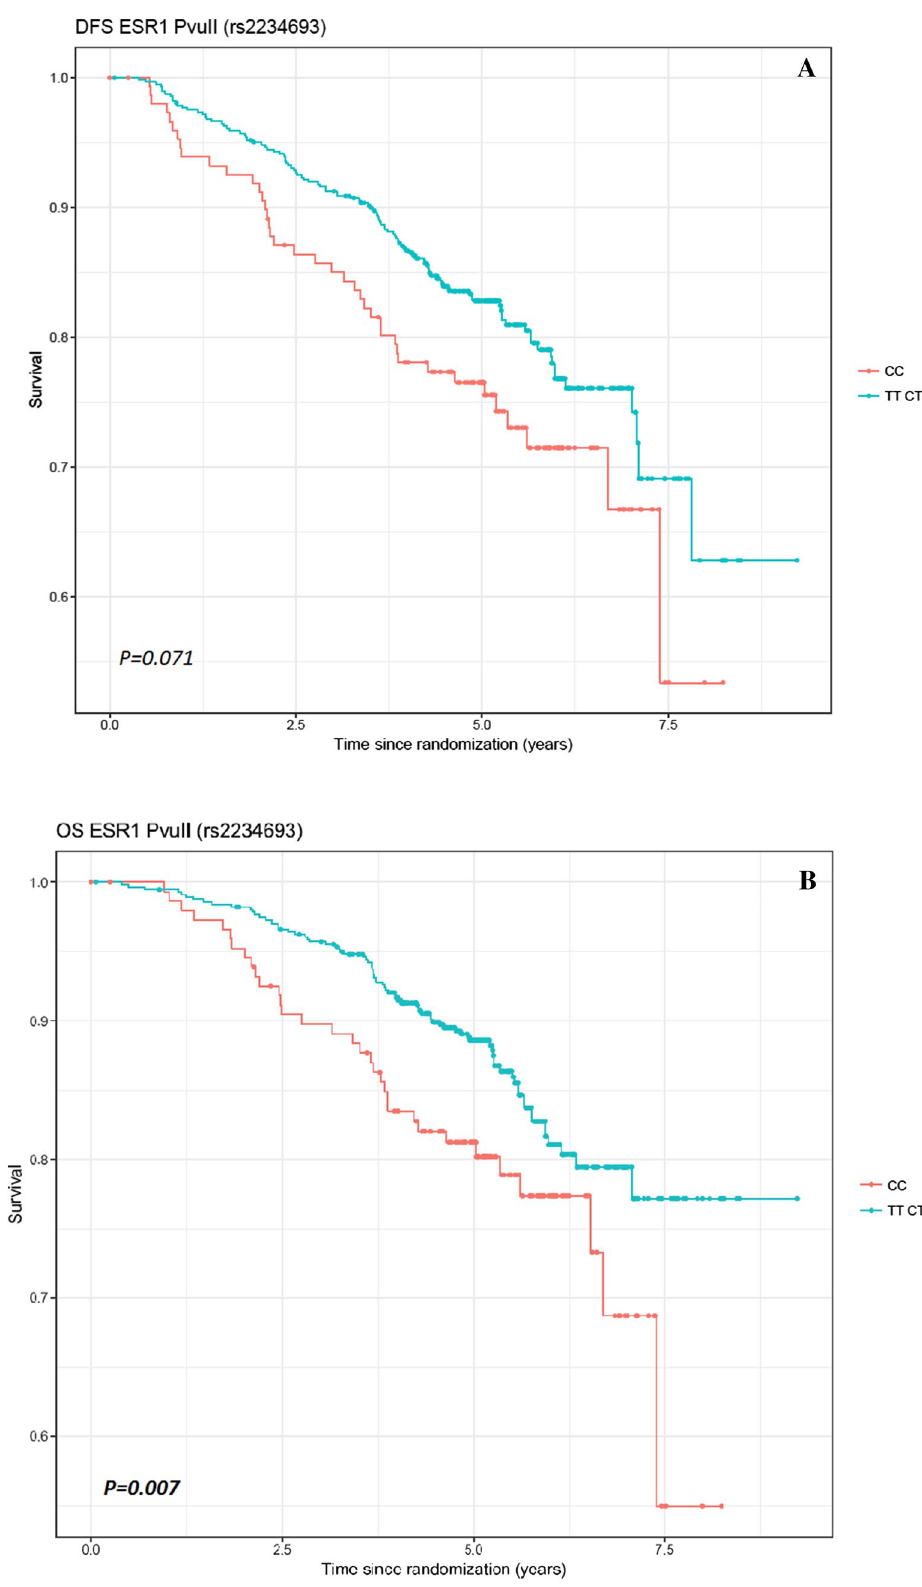
Figure 2. Kaplan–Meier curves of disease-free survival ( A ) and overall survival ( B ) for rs223469. Note : P-values are given for the multivariate analyses of the Cox regression analyses. DFS, disease free survival; OS, overall survival, ESR1, estrogen receptor